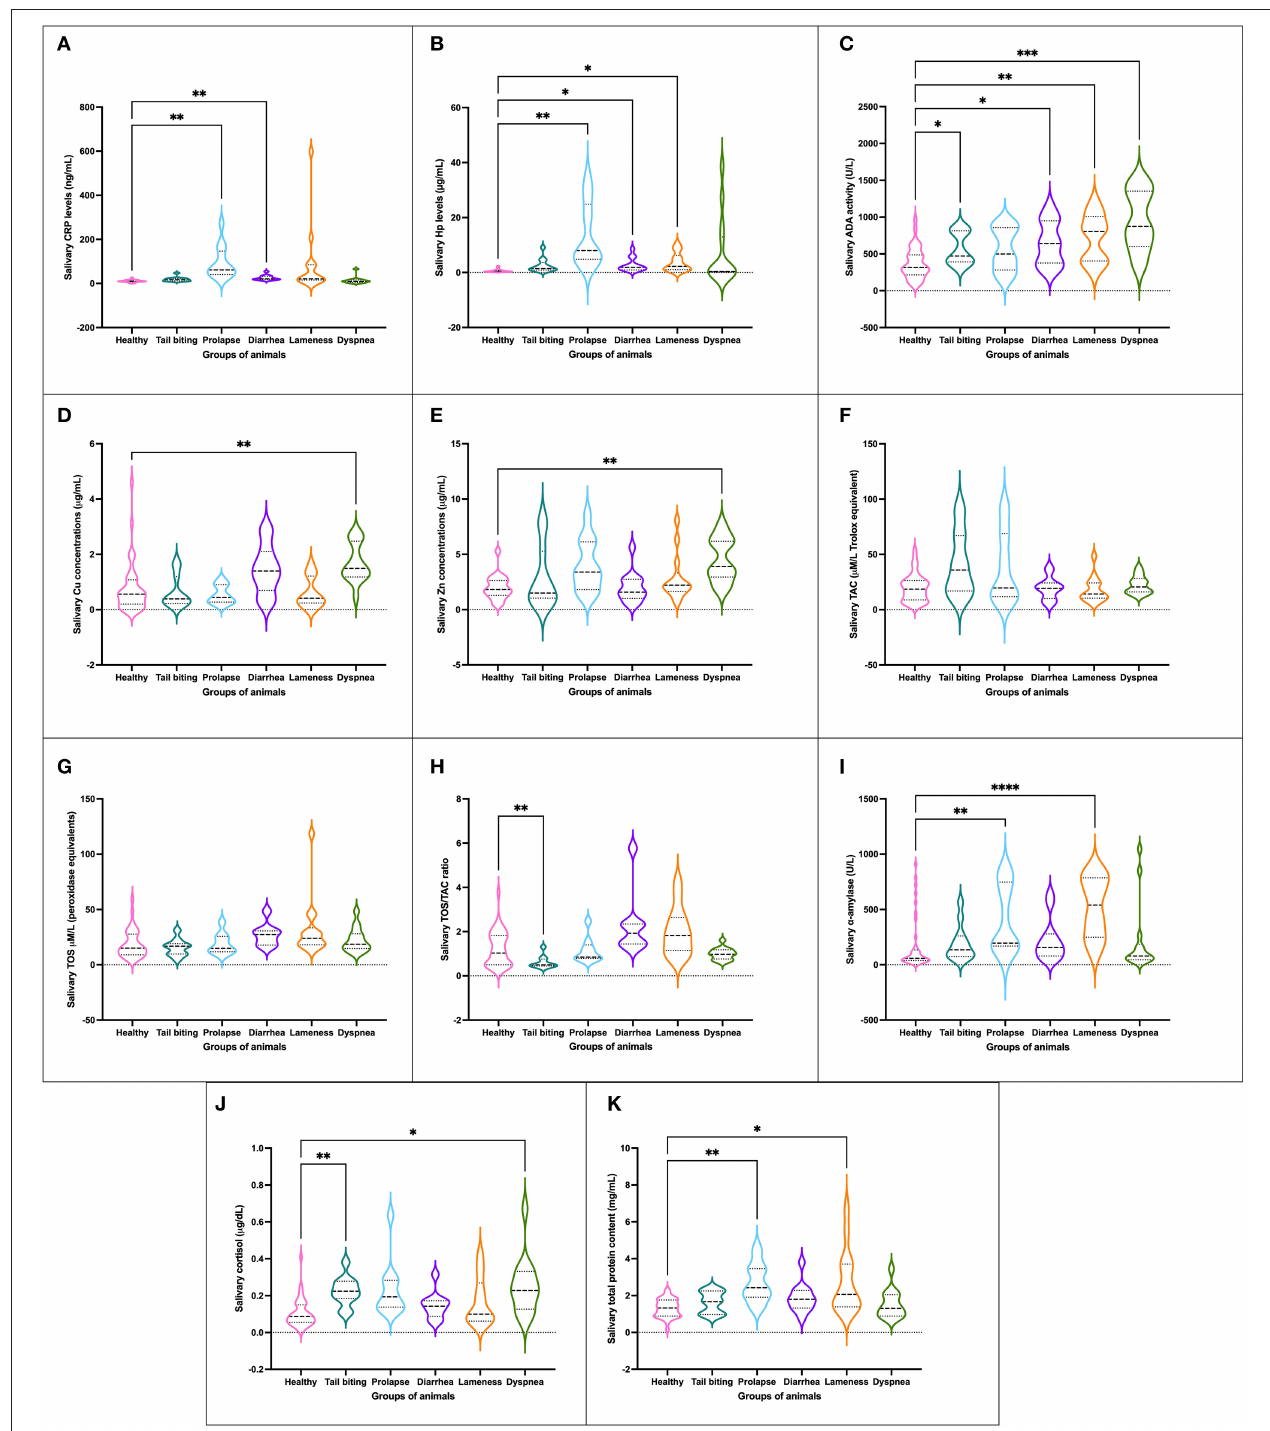
FIGURE 1 | Concentration of salivary analytes studied [CRP (A) , Hp (B) , ADA (C) , Cu (D) , Zn (E) , TAC (F) , TOS (G) , ratio TOS/TAC (H) , salivary alpha-amylase (I) , cortisol (J) and TP (K) ] in healthy pigs ( n = 40) and animals suffering from a pathological condition (tail-biting lesions n = 13, rectal prolapse n = 13, diarrhea n = 13, lameness n = 14, or dyspnea n = 14). Graph showing the distribution of the population (depending on whether the plot is widening or narrowing), the median (central horizontal line), 25th and 75th percentiles (non-central horizontal lines within the plot), maximum and minimum (edges of the figure). Statistical differences are indicated by * , ** , *** , and **** for p < 0.05, p < 0.01, p < 0.001, and p < 0.0001, respectively. CRP, C-reactive protein; Hp, haptoglobin; ADA, adenosine deaminase; TAC, total antioxidant capacity; TOS, total oxidant status; TP, total protein.